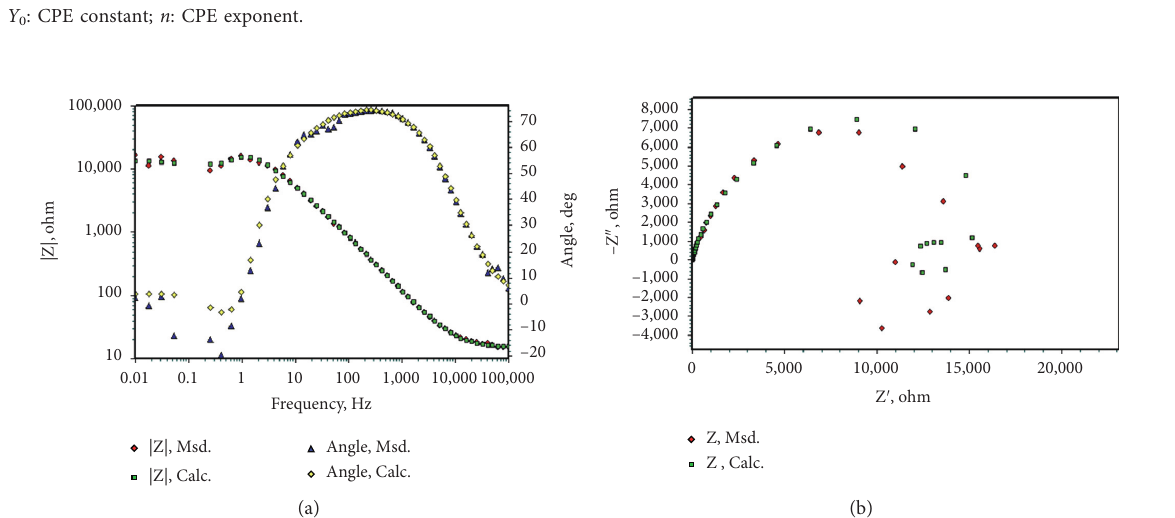
Figure 8: (a) Bode and (b) Nyquist curves of MAO coating after being immersed in 3.5 wt.% NaCl solution for 12